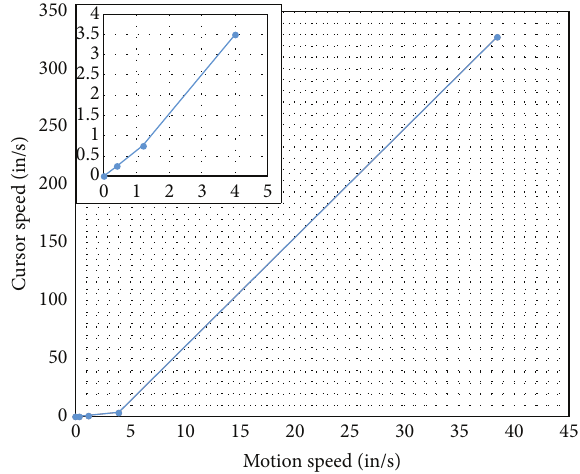
Figure 4: The pointer acceleration curve used in the experiment. The figure depicts the curve with a multiplier of 1.0. The curve represents the relationship between input speed and output speed. A CD gain curve can be derived by dividing each point on the curve by its input speed.